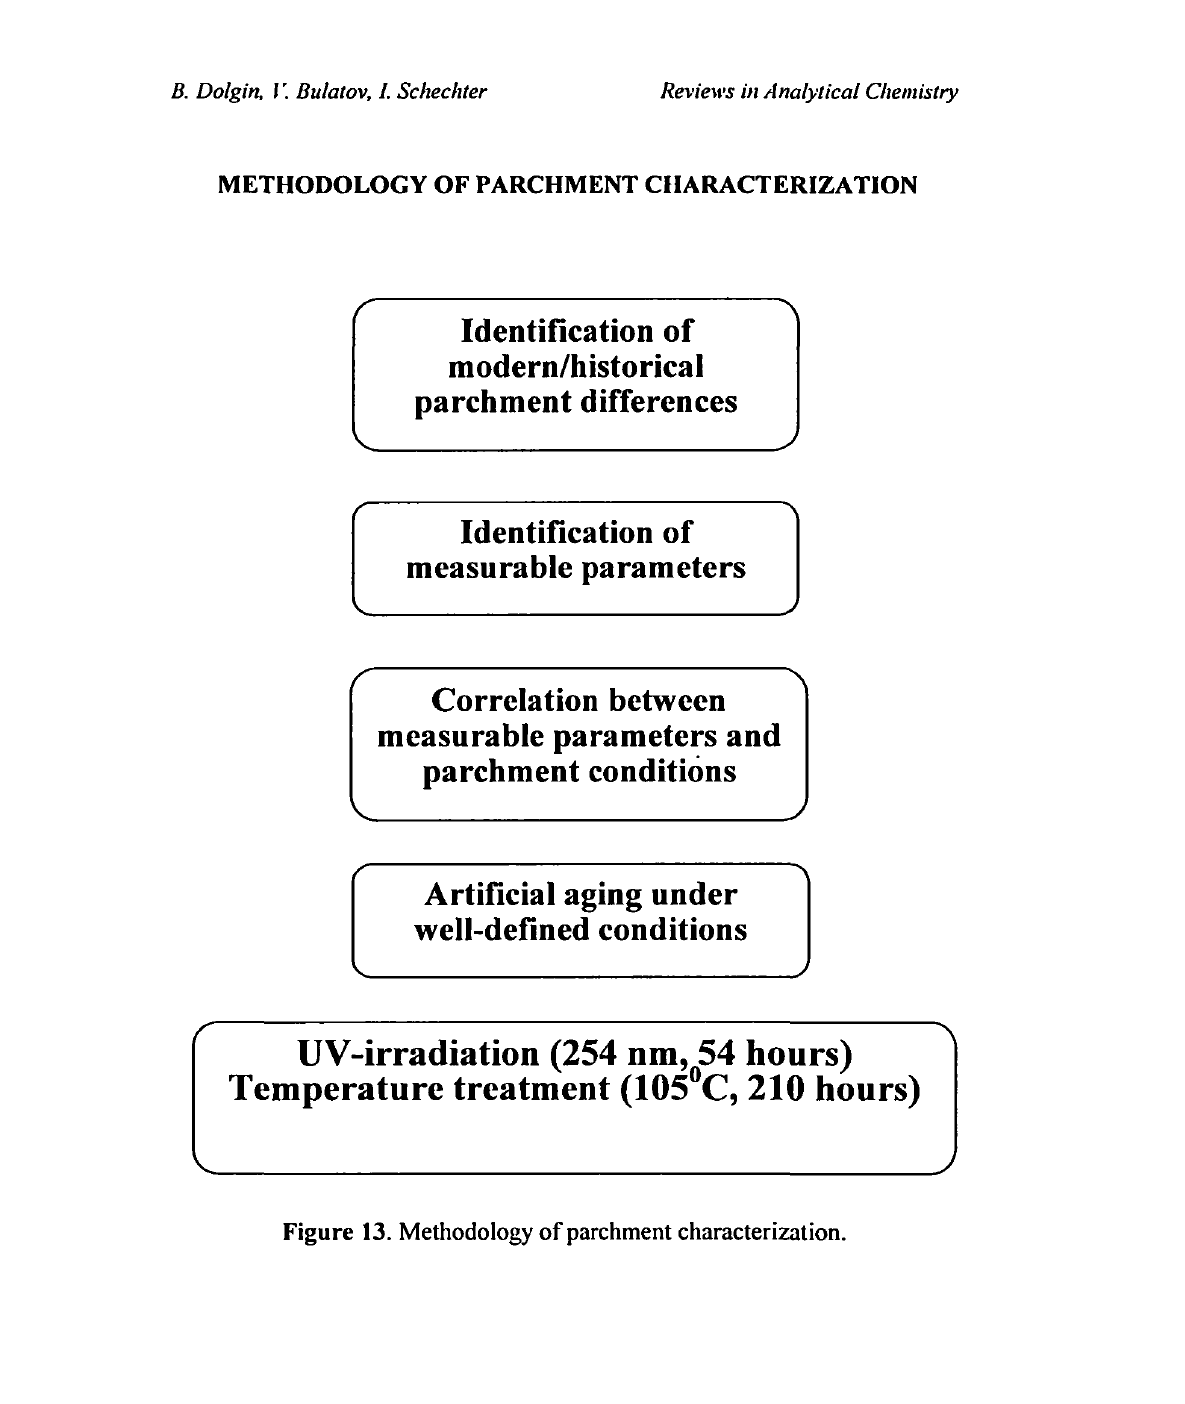
Figure 13. Methodology of parchment